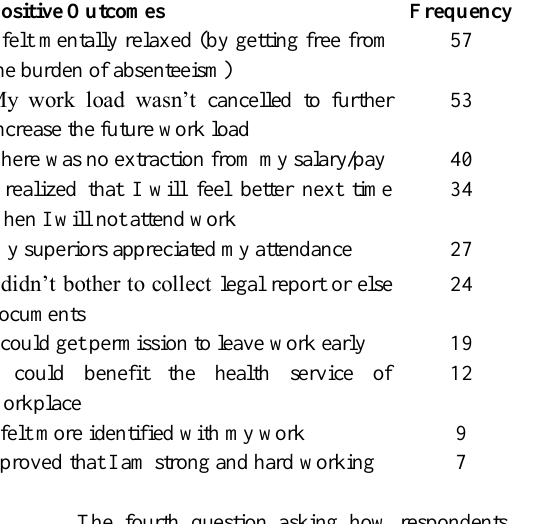
Table 3: Positive Outcomes Listed for Presenteeism by Respondents